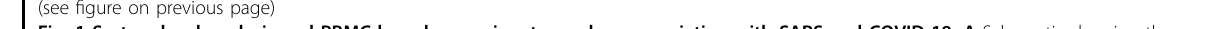
C , D . CoV-Up-gene signature scores ( C ) and CoV-Down-gene signature scores ( D ) and their association with SARS-CoV-2-infected (COVID-19; n = 3) patients and healthy individuals ( n = 3; datasets from Xiong et al. 17 ). For C and D statistical signi fi cance was not considered due to low sample size. E , F . CoV-Up-gene signature scores ( E ) and CoV-Down-gene signature scores ( F ) and their association with acute and recovering SARS-CoV-infected patients ( n = 25; 44 samples), bacteria-infected patients ( n = 16), and healthy individuals ( n = 9; datasets from Lee et al. 19 ). Kruskal – Wallis statistical test with p < 0.001 for E and F . G Acute vs. recovering gene signature from Lee et al. 19 predicted acute-like and recovering-like SARS-CoV-infected patients ( n = 10) from Raghunathan et al. 16 using NTP method and cosine distance